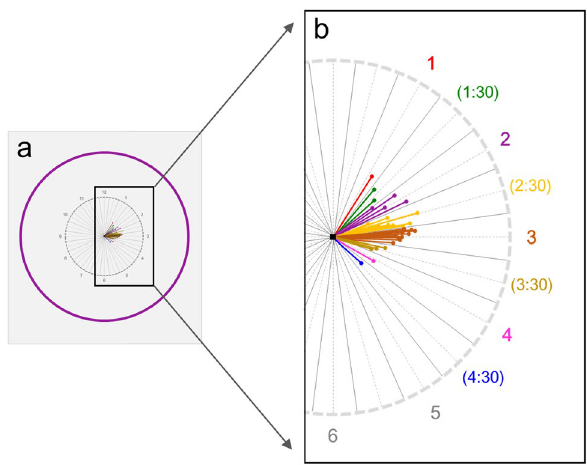
Figure 1. Diagram showing directional vectors of scan-circle center movement from baseline to final visit in study subjects. ( a ) Direction and amount of center shift presented in SD-OCT scan circle (purple solid circle: SD-OCT scan circle; purple dotted circle: virtual optic disc margin). The distance of center shift was calculated as the relative length compared with the scan-circle diameter. Also, the disc-fovea axis was aligned in the 3 o’clock direction in each case. ( b ) Magnification image of black square in ( a ). The major directionality of the scan-circle shift was to the nasal side of the optic disc. The scan-circle center movement was most frequent toward 3 o’clock (n = 14), followed by 2.5 (n = 10) and 2 o’clock (n = 4).